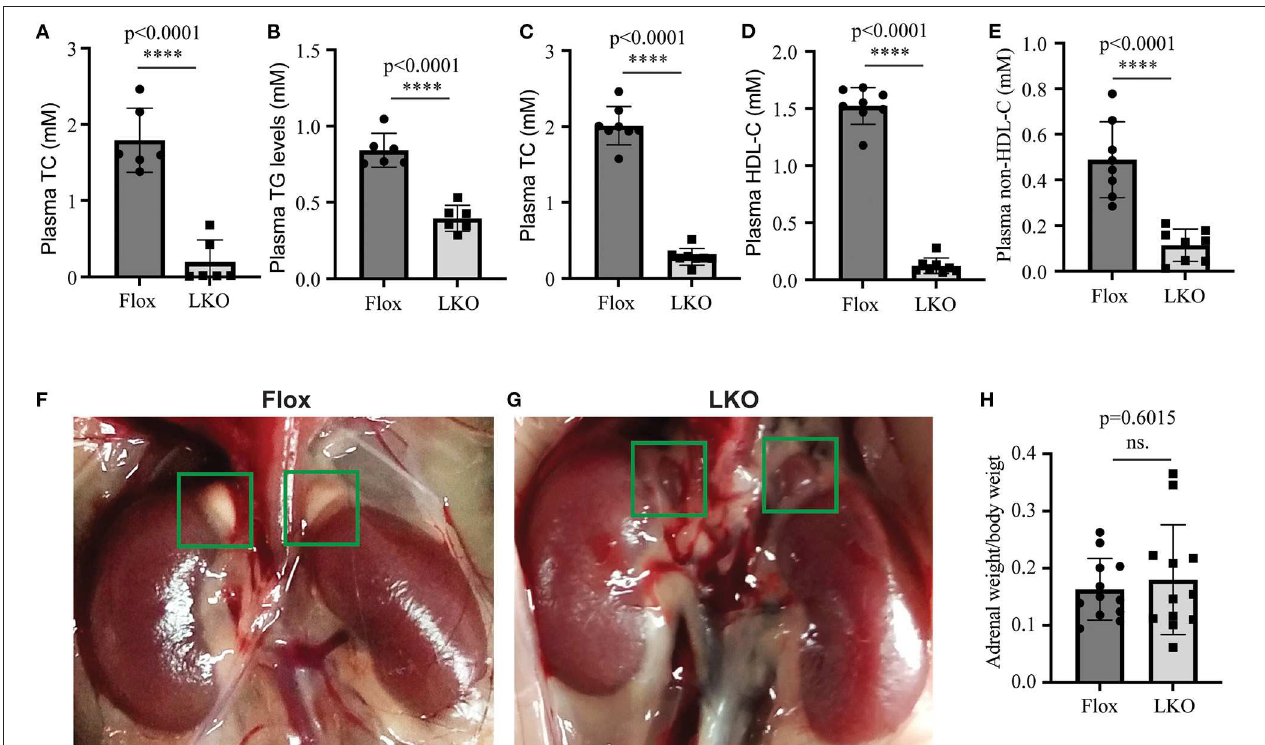
FIGURE 1 | The effect of hepatic knockout of Surf4 on plasma lipids and the adrenal gland. (A–E) Plasma lipid levels. Blood samples were collected from 4-week-old mice (A,B) fasted for 10h or 14-week-old mice fasted for 10h and refed for 4h (C–E) . Plasma levels of total cholesterol (TC), triglycerides (TG), and HDL cholesterol (HDL-C) were measured using their specific enzymatic kits ( n ≥ 6). Non-HDL-C was calculated by subtracting HDL-C from TC. (F,G) Representative images of the adrenal glands of Surf4 Flox (F) and Surf4 LKO mice (G) (green frame). Similar results were observed in other mice. (H) Ratio of the adrenal weight to the body weight of the same mouse. Values of all data were mean ± S.D. The significance was defined as **** p < 0.0001 and P > 0.05, no significance (ns.).